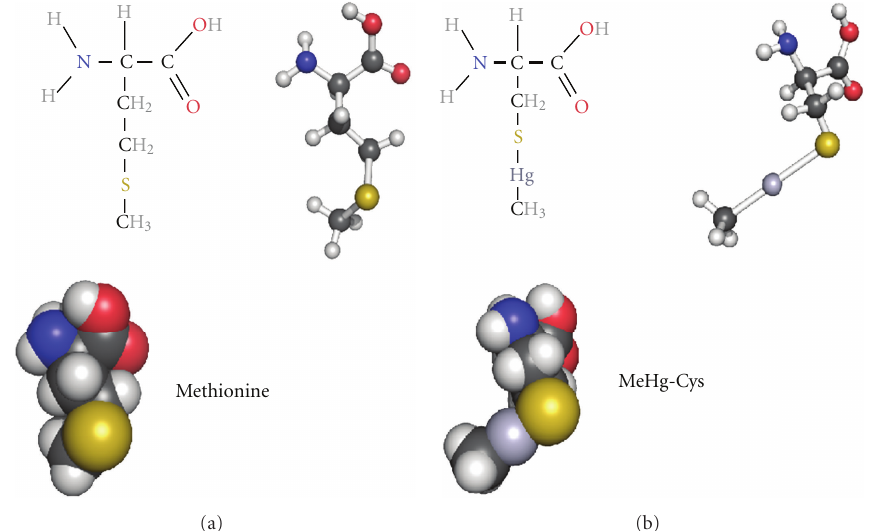
Figure 2: Schematic representation of the structures and space-filled models of methionine (a) and MeHg-Cys complex (b). Note the similarities in chemical structure between the MeHg-Cys conjugate and the amino acid methionine. The geometry-optimized using Universal Force Field (UFF). The representations (ball and stick, Vander Waals spheres) were obtained using the program PyMOL (Molecular Graphics System, Version 1.5.0.1, Schr¨odinger LLC).